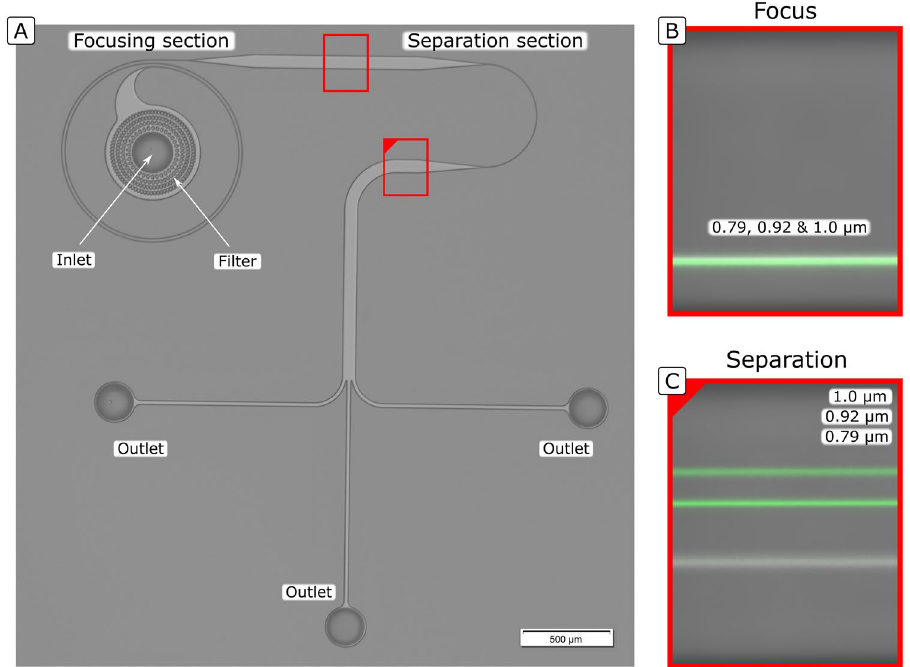
Figure 6. ( A ) View of HARC system under the microscope. ( B ) Example of performance of the focusing section (two loops, R 500 µm, 6.15 × 14.5 µm ( W × H ), Q 32 µL/min). ( C ) Example of performance of the separation section (half loop, R 200 µm, 6.15 × 14.5 µm ( W × H ), Q 32 µL/min).